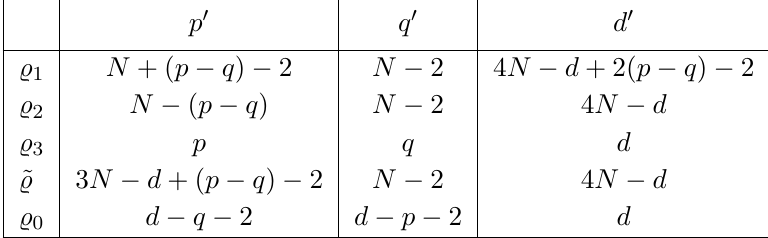
Table 2 . The action of symmetries in table 1 on the parameters ( p; q ; d ) that characterize a con(cid:12)guration of two defects. As in table 1 the symmetry transformation ~ % is accompanied by a shift of coordinates. The last row is new and results from the fact it is not possible to reconstruct the parameters ( p; q ; d ) uniquely from the coupling constants k i